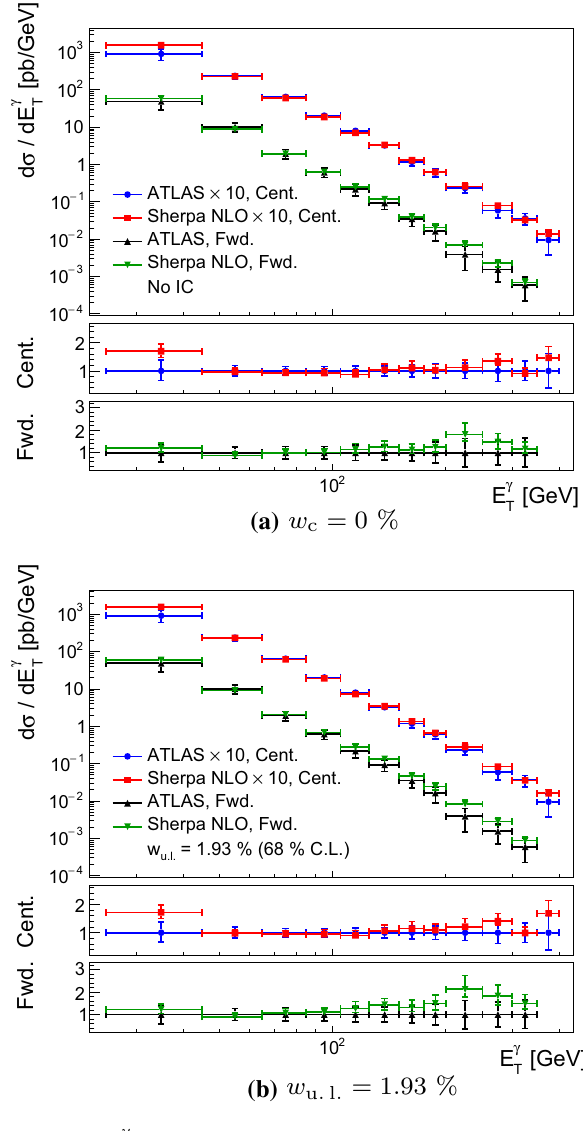
γ Fig. 1 The E -spectrum calculated with the Sherpa MC generator at T NLO compared to the ATLAS data [32]. a Top: the spectrum at central rapidity | η γ | < 1 . 37 and forward 1 . 56 ≤ | η γ | < 2 . 37 region without the IC contribution; a middle: the ratio of the MC calculation to the data for the central rapidity region ( w c = 0 %); a bottom: the ratio of the MC calculation to the data for the for forward rapidity regions ( w c = 0 %). b The same spectra, as in ( a ), but with the upper limit of IC contribution w u . l . = 1 . 93 %